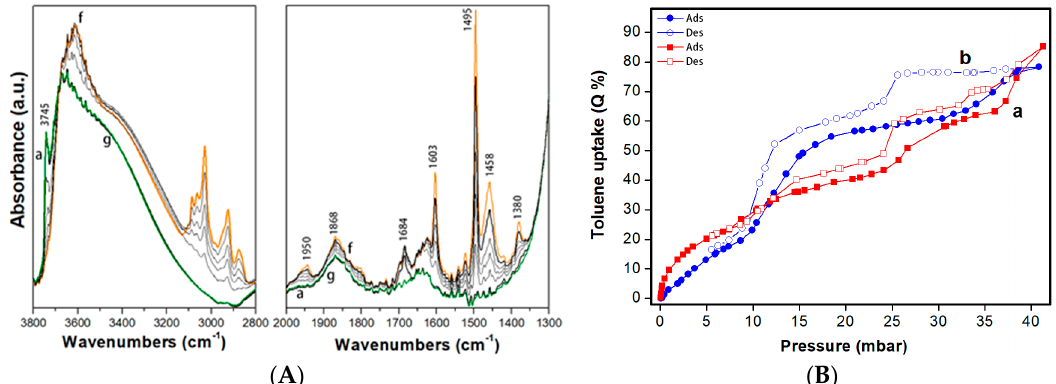
Figure 4. ( A ) FT-IR spectra of calcined Mono-ICE sample after outgassing at RT for 1 h (curve a, green), after dosages of 5, 10, 15, 20 mbar up to 30 mbar of toluene (curve f, orange), and after evacuation of toluene at RT for 30 min (curve g). ( B ) Toluene volumetric adsorption (full symbols) and desorption (empty symbols) isotherms of toluene at 35 ◦ C on calcined Mono-ICE (a, (cid:4) ), and MCM 41 (b, • ) samples.